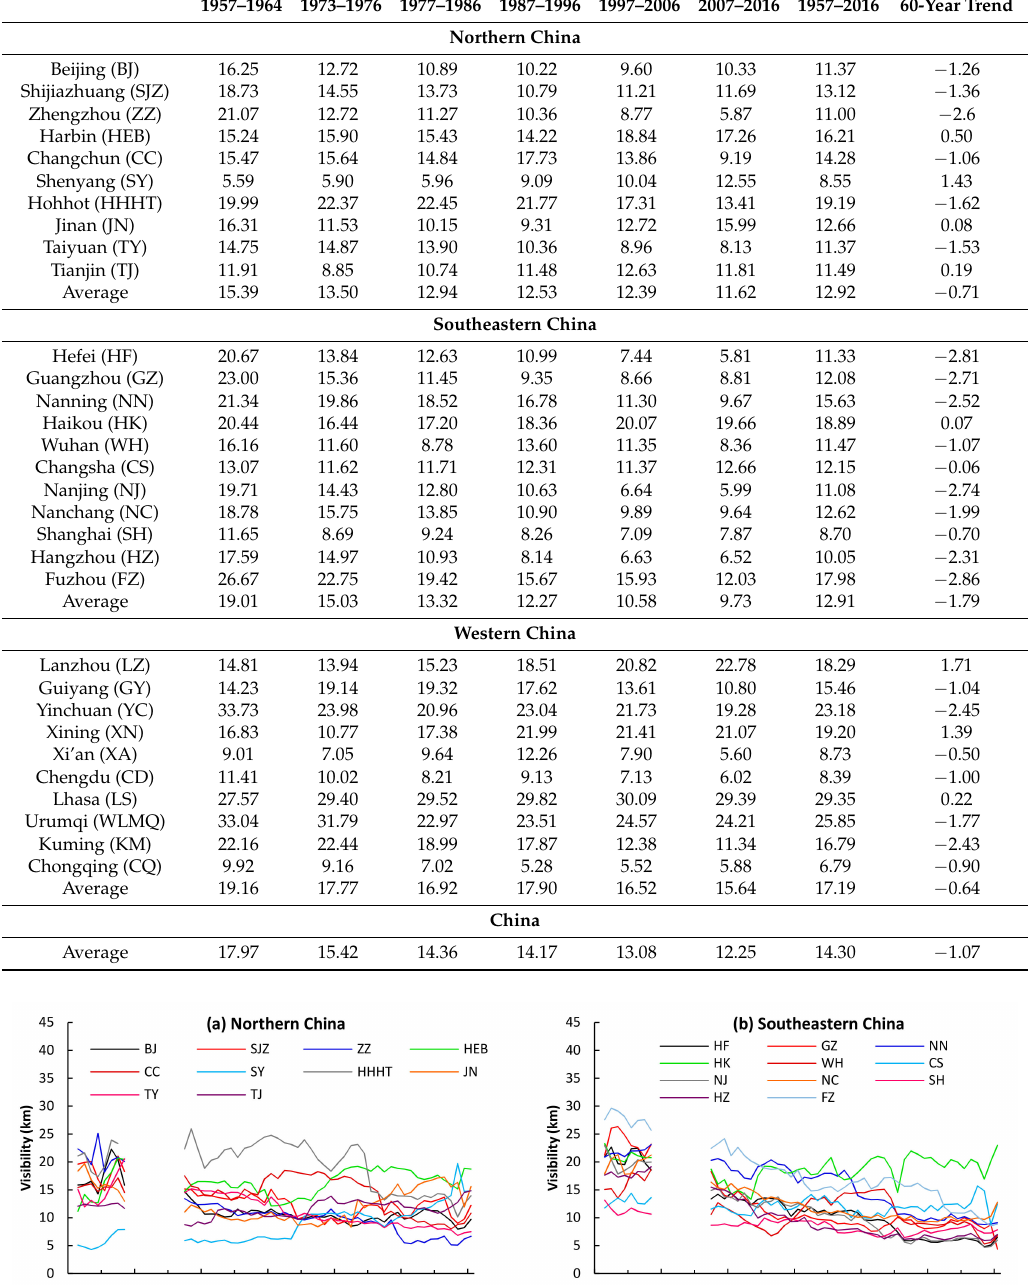
Table 2. Mean visibility (km) and change trends (km/decade) of the six decades of the 31 provincial capital cities in